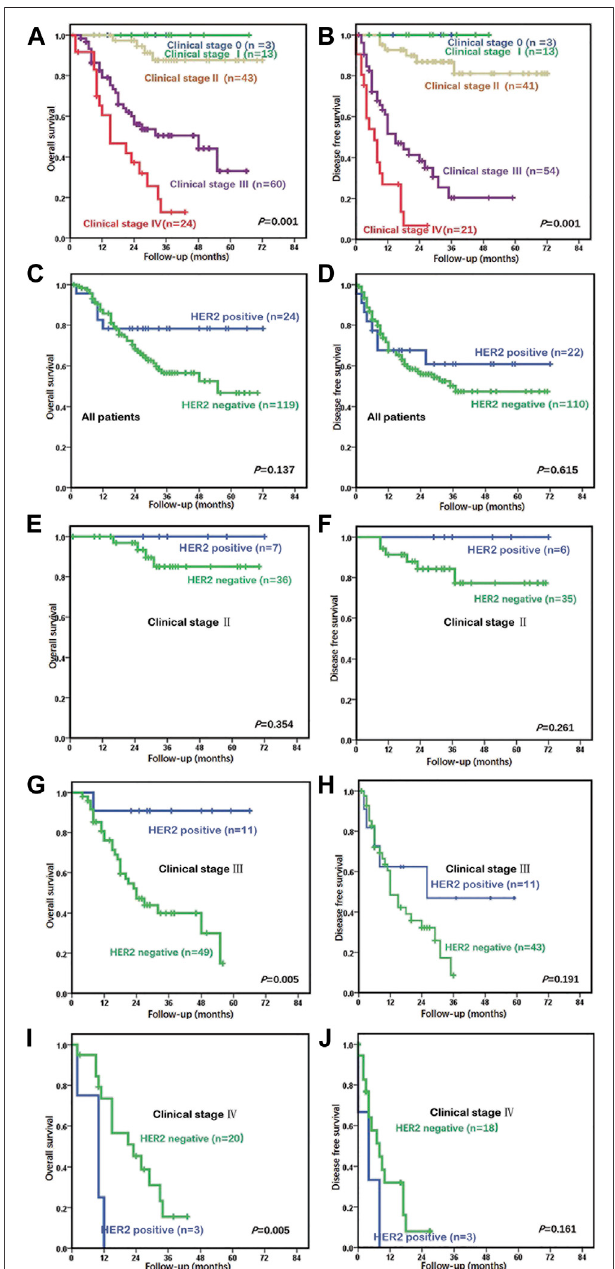
FIGURE 2 | Relationship between prognosis and clinical stages and HER2 status in adenocarcinoma (AC) patients who underwent curative surgeries. (A) Clinical stage was markedly related to overall survival (OS) ( p = 0.001)in all143patients. Themedian OSwas48 months in stageIII and was 15 months in stage IV. (B) Clinical stage was related to disease-free survival(DFS)( p =0.001).ThemedianDFSwas15 monthsinstageIIIandwas 7 months in stage IV. (C) In the univariate analysis of all 143 patients, those with HER2 positivity tended to have better OS compared to those with a HER2-negativestatus,butthe fi ndingwasnotsigni fi cant( p =0.137). (D) Inthe univariate analysis of 143 patients, those with HER2 positivity did not show worse or better DFS in comparison to patients with a HER2-negative status ( p =0.615). (E) InstageII,theprognosticoutcomeoftheHER2-positivegroup